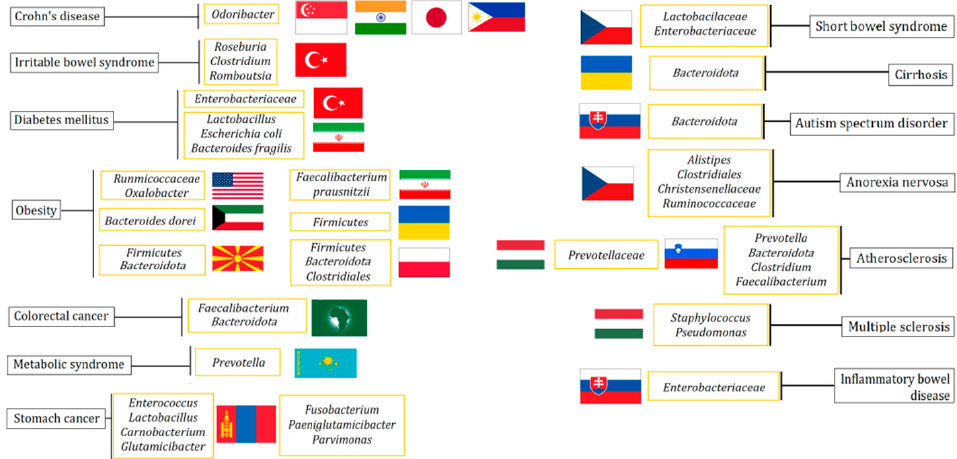
Figure 2. Bacterial taxa are typical of residents of different countries, the composition of which predominates during the development of the